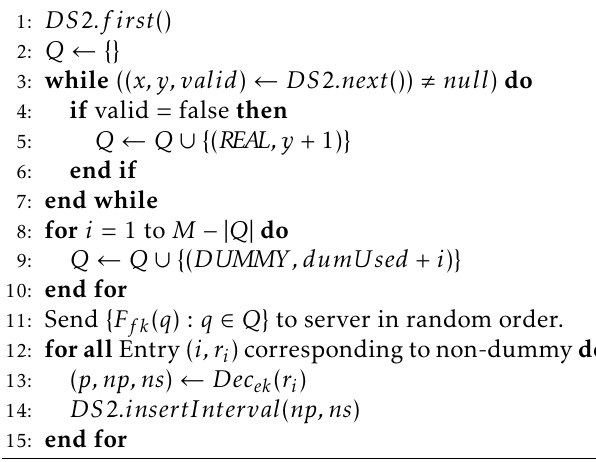
Algorithm 9 V alidateAllIntervals